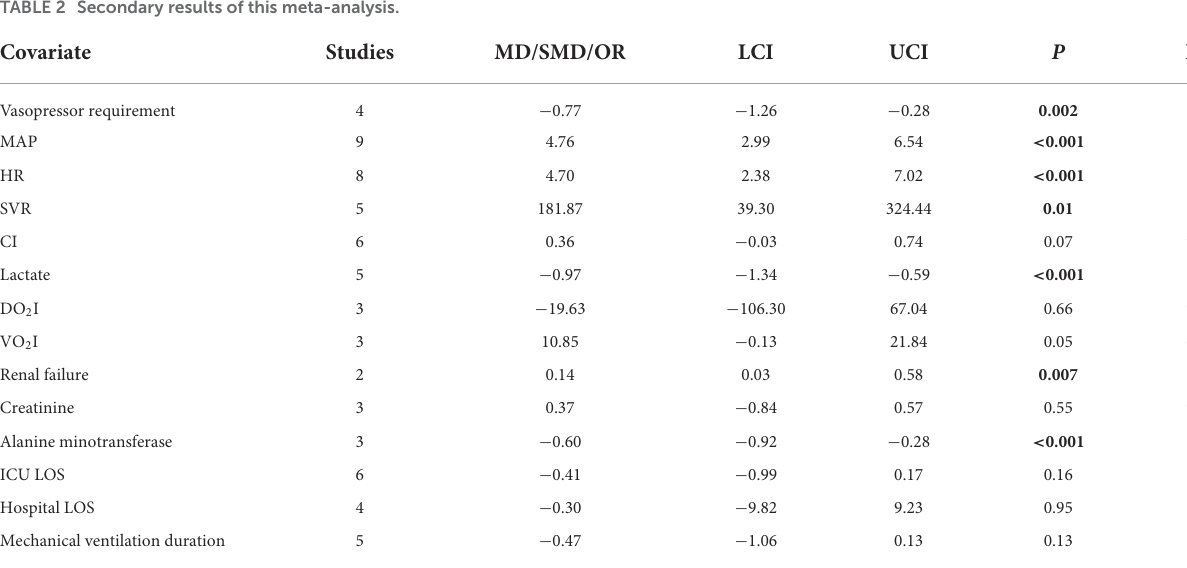
TABLE 2 Secondary results of this